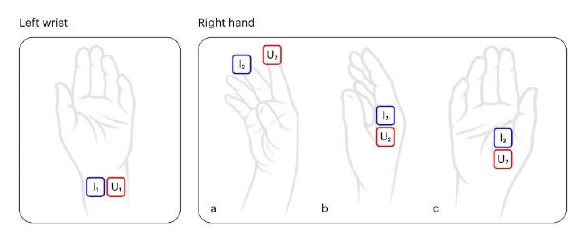
Fig.2: The positions of the WIM electrodes on the left wrist and right hand during bioelectrical impedance measurement.